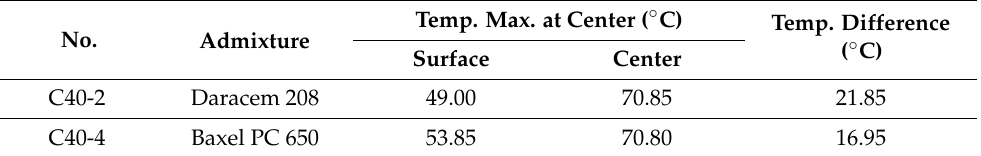
Table 16. Results of measured temperature data (replacement of GGBS 65%).